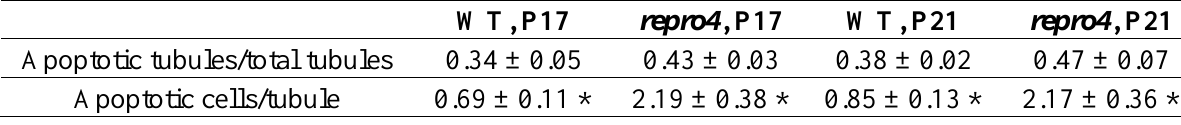
Table 2. Analysis of apoptosis in repro4